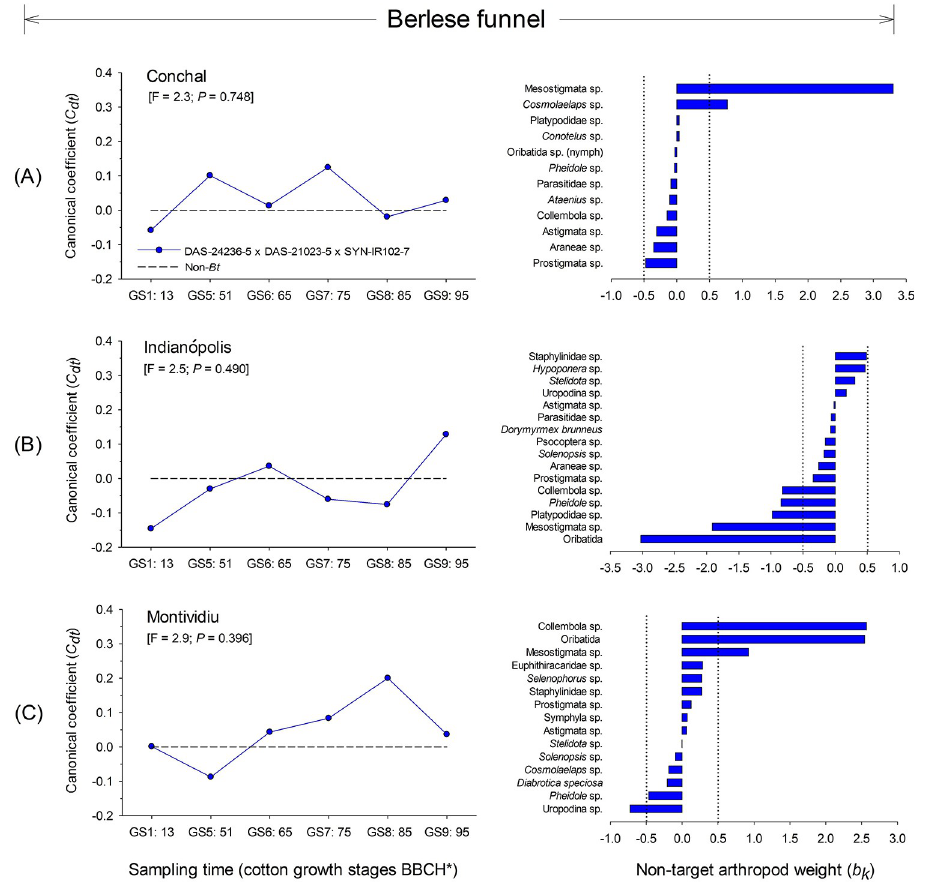
Fig 11. Principal response curves (PRCs) and taxon weights of ground-dwelling arthropod populations collected via soil extraction from DAS-21023-5 × DAS-24236-5 × SYN-IR102-7 Bt cotton compared with a non- Bt variety at three sites in Brazil (2014/2015 cropping season). Dotted line indicates the response within the non- Bt cotton entry. If a significant P-value was detected ( < 0.05, Monte Carlo test), taxa with positive weights followed the PRC pattern, whereas those with negative weights showed the opposite pattern. Taxa with weights between approximately -0.5 and 0.5 did not contribute significantly to the overall pattern. If a P-value was non-significant, species patterns were random in relation to treatments. � Phenological growth stages of cotton classified according to Munger et al.